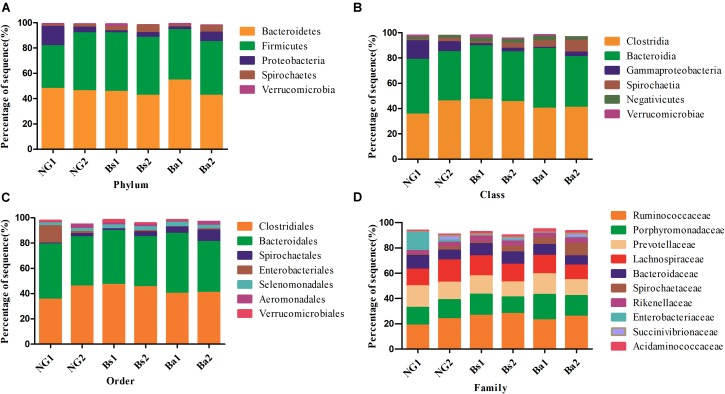
Bacteria distributions using V3–V4 amplicon sequencing at phyla (A), class (B), order (C), family level (D); 1-pre-intervention, 2-post-intervention.